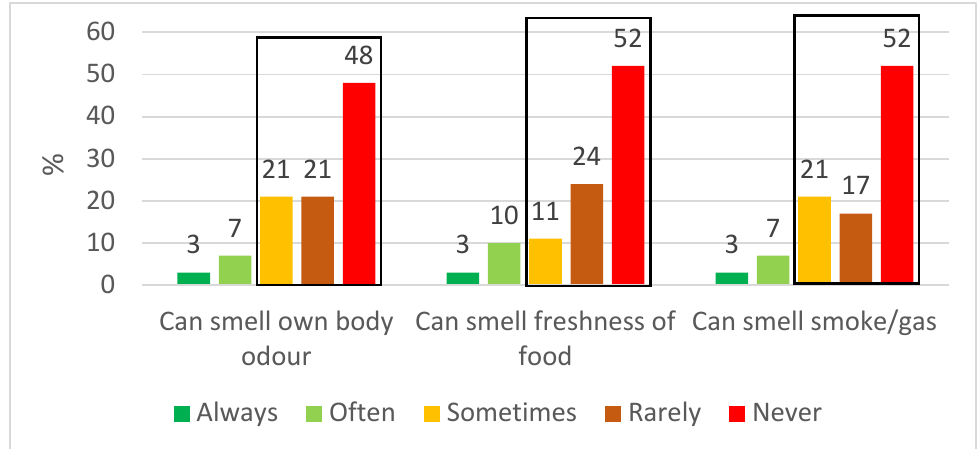
Figure 1. HRQoL; patients’ ability to navigate everyday life using their sense of smell and taste 3–6 months after hospitalisation for COVID-19 ( n = 29). The black box shows the percentage of patients where this ability was decreased.